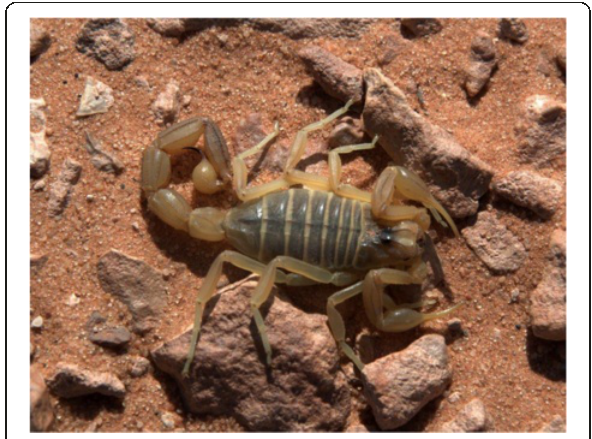
Fig. 4 Buthus saharicus Sadine, Bissati & Lourenço, 2016; female Fig. 5 Androctonus australis (Linnaeus, 1758); female from Algeria (copyright by Eric Ythier, reproduced with